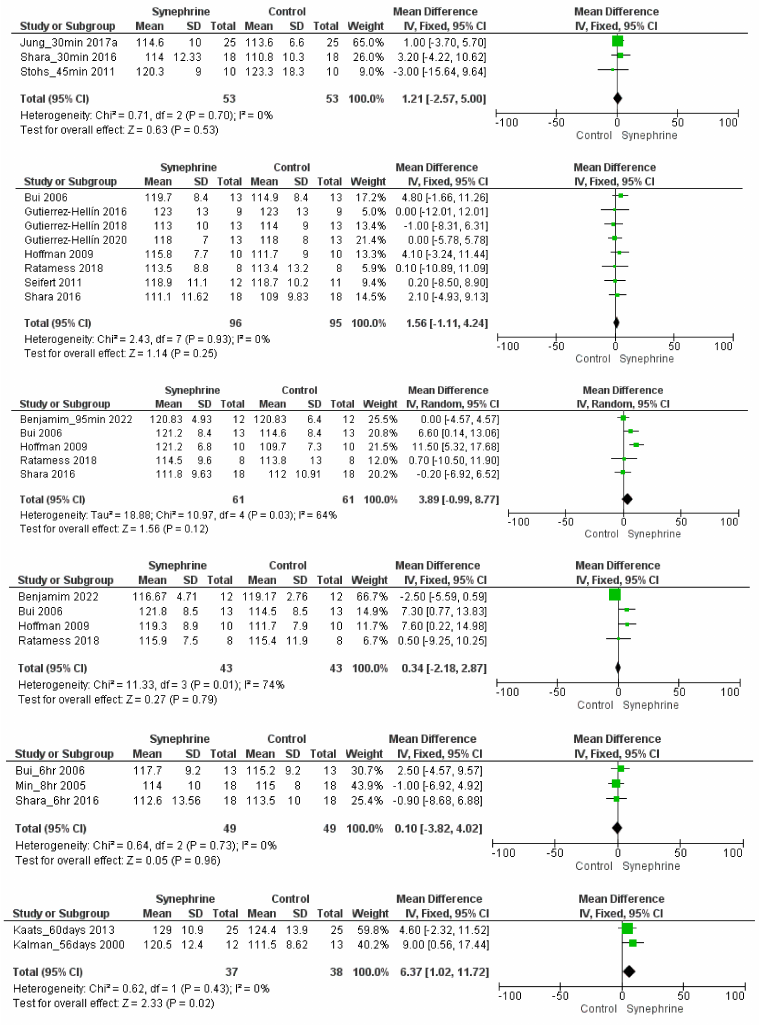
Figure 3. Forest plot diagram of synephrine on systolic blood pressure acutely (after 30–45 min; 1 h; 2 h; 3 h; and 6–8 h) and long-duration (56–60 days) in intervention and control groups. The dosages and the included articles were the same in DBP; one difference was that we left one datum point out by 2 h [49], as the statistical SD value “0” could not have been estimated. The administration of synephrine (20–214 mg) did not significantly alter the DBP 30-45 min after administration (MD: − 0.88 mmHg, 95% CI: − 4.45–2.70, p = 0.63); 1 h after administration (MD: − 0.89 mmHg, 95% CI: − 2.92–1.13, p = 0.39); 2 h after administration (MD: 0.48 mmHg 95% CI: − 2.22–3.17, p = 0.73) (four articles; 49 subjects; 49–108